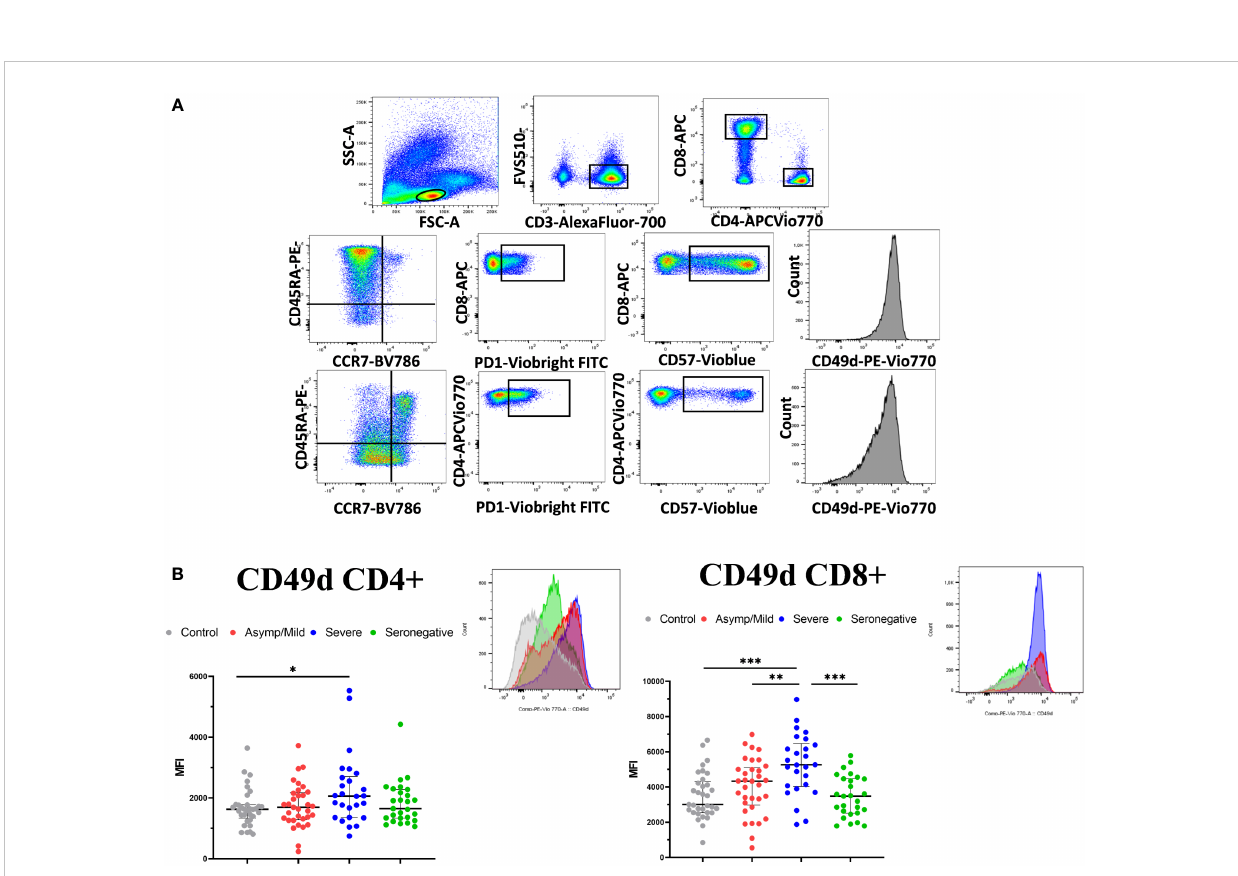
FIGURE 5 T-cell phenotypic characterization of PBMCs in convalescent COVID-19 patients and healthy controls. (A) Gating strategy for analyzing PBMC phenotype. Live CD3+ cells were selected and CD4+ and CD8+T cells were gated separately to analyze memory and naïve T cells (CD45RA/CCR7), expression of late memory markers (PD-1 and CD57) and integrin CD49d. (B) PBMCs were assessed for expression of CD49d on CD4+ and CD8+ T cells. Data represent the MFI. A representative histogram of each group is shown above the scatter plot. Median and IQR are shown. The Mann – Whitney test was used. *<0.05, **<0.01,